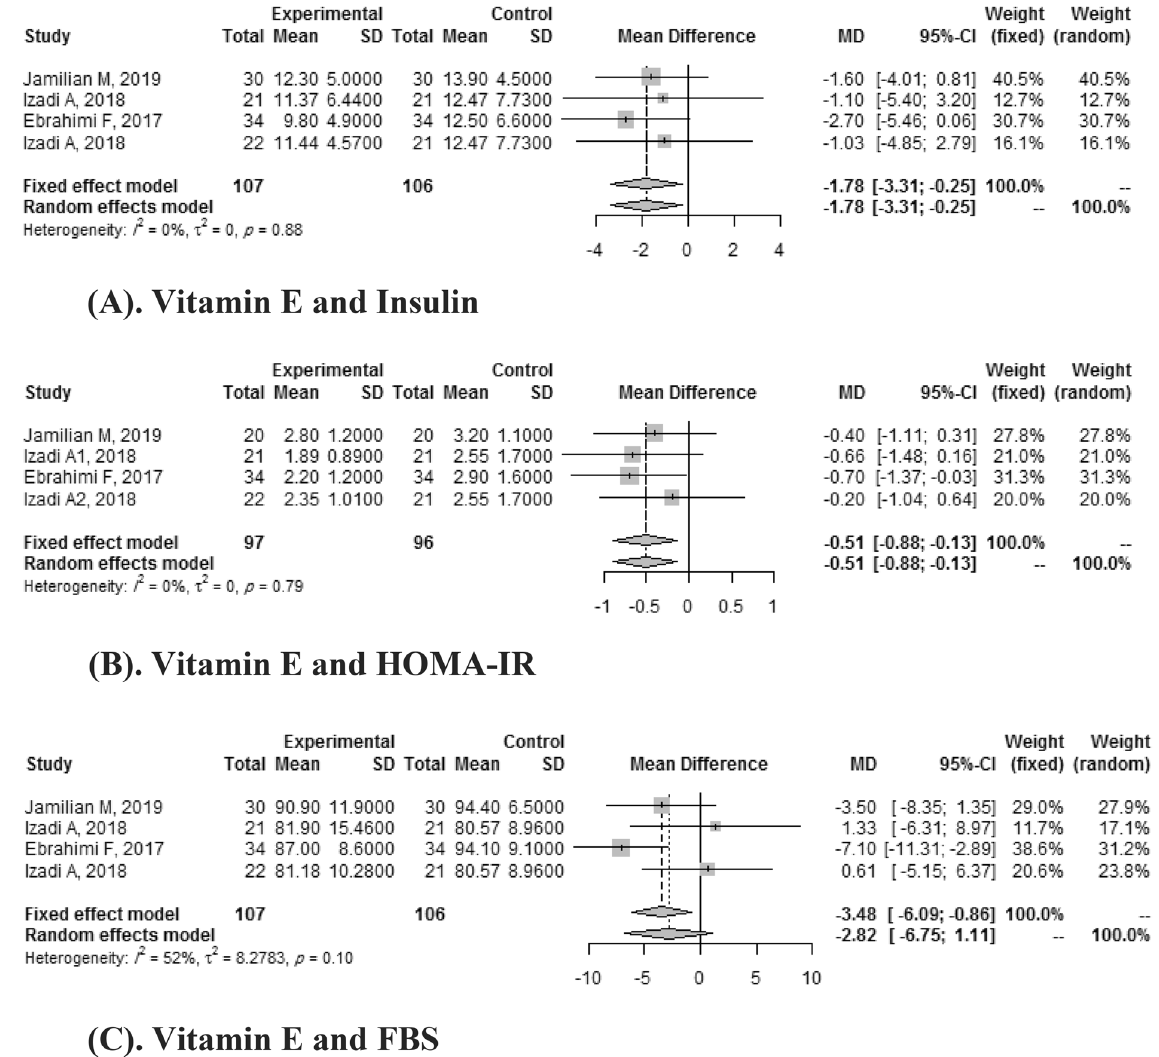
Figure 7. ( A ) Vitamin E and insulin. ( B ) Vitamin E and HOMA-IR. ( C ) Vitamin E and